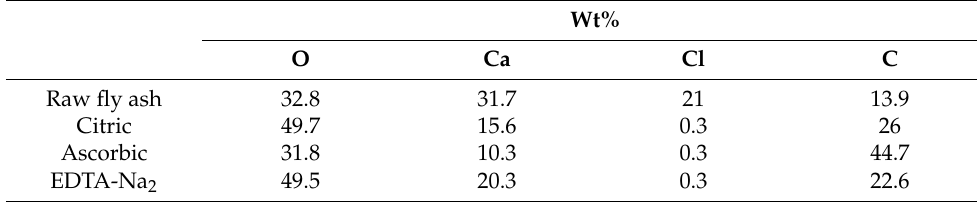
Table 3. Element content of fly ashes.